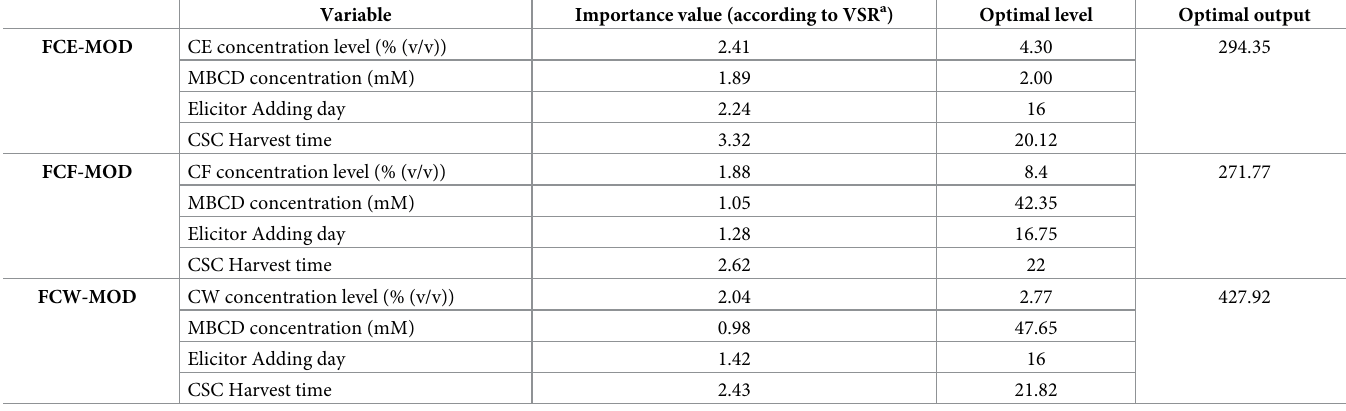
a Relative indication of the ratio between the variable sensitivity error and the error of the model when all variables are